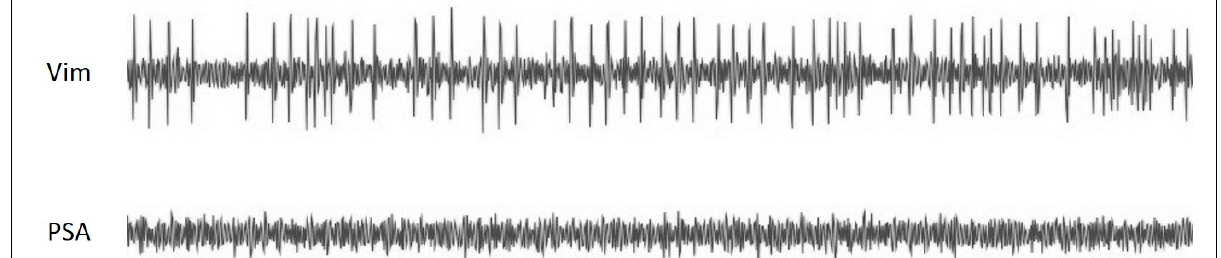
Figure 4. The canonical neuronal firing patterns of the Vim and PSA. The neuronal firing patterns from intraoperative MER are among the critical factors for selecting the electrode implantation site for the Vim–PSA double-target DBS surgery. Generally, the high background firing activity of neurons corresponding to tremors can be recorded in the Vim nucleus. On the other hand, the neuronal firing pattern of the PSA is characterized by low background noise and sparse neuronal firing.